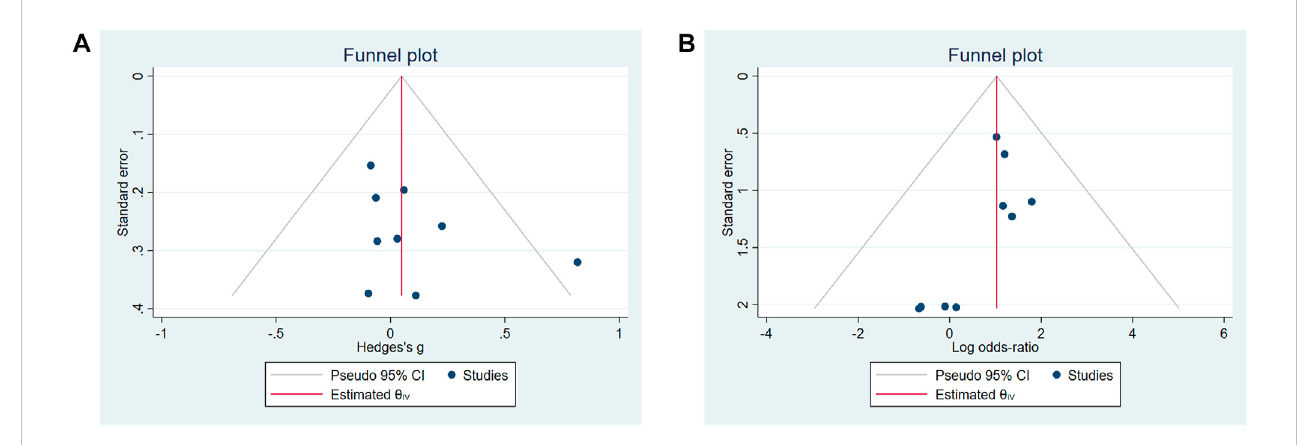
FIGURE 3 Funnel plots of the publication bias. (A) Change of unstimulated whole saliva (UWS). (B) Occurrence of serious adverse events (SAEs).